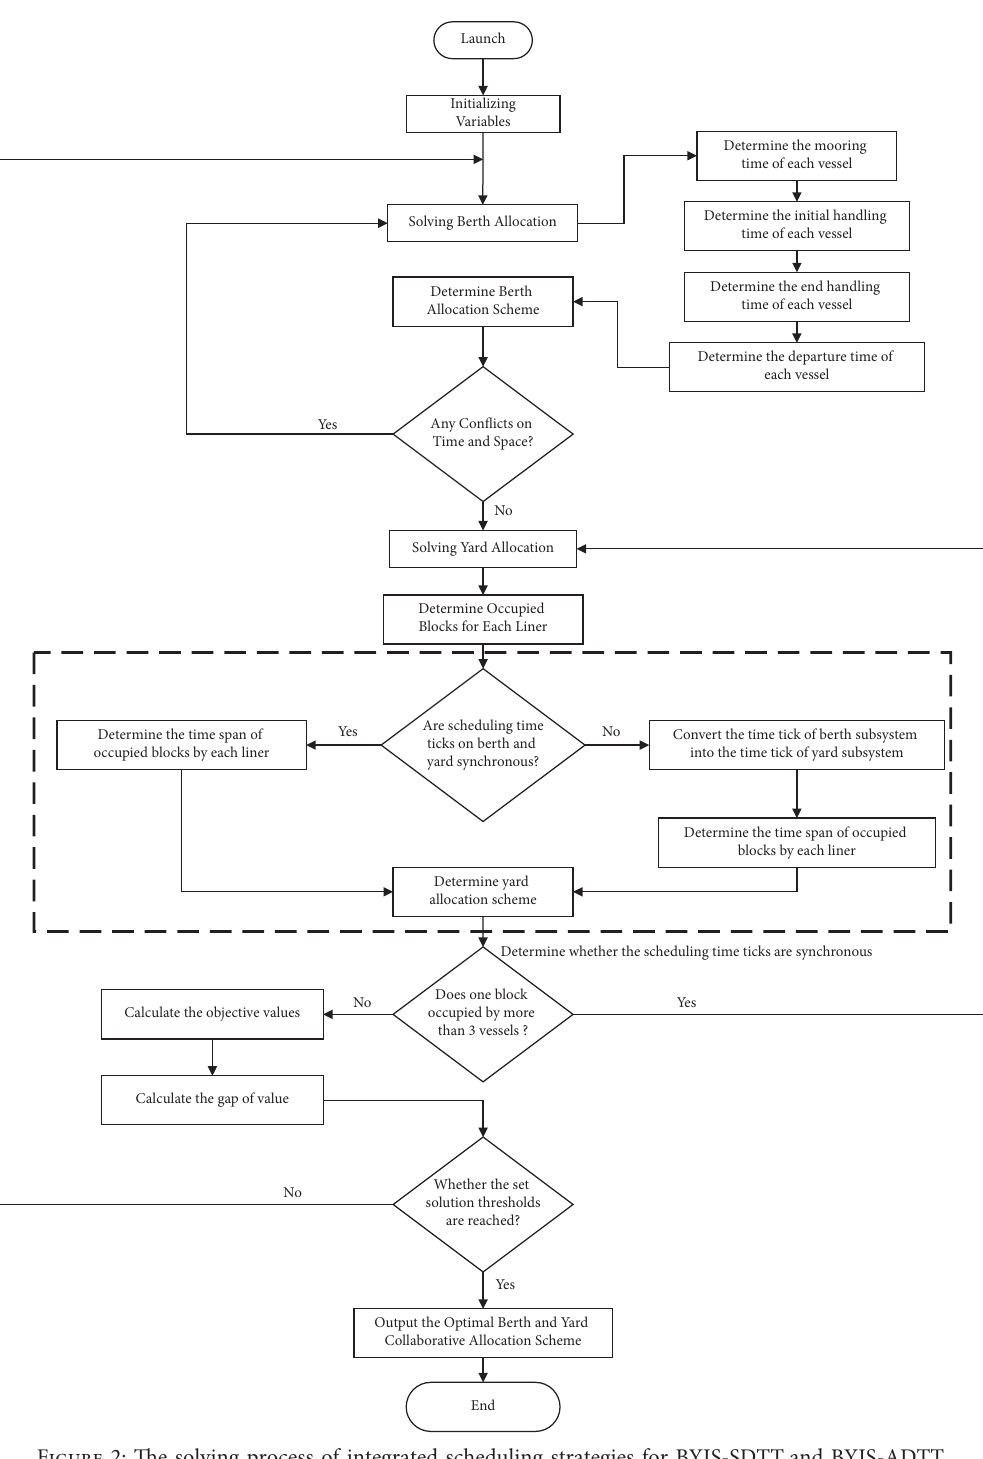
Figure 2: The solving process of integrated scheduling strategies for BYIS-SDTT and